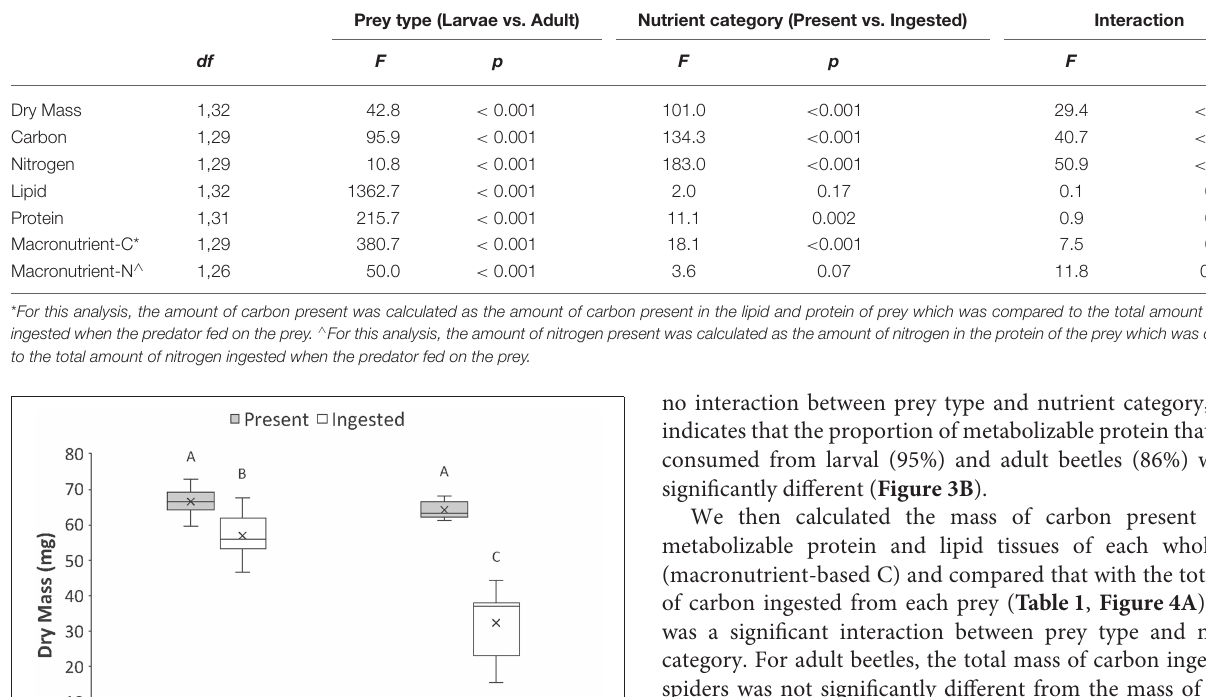
TABLE 1 | Results of the statistical analysis (2-factor analysis of variance) comparing nutrients present in whole prey bodies with nutrients ingested by predators feeding on those prey for larval and adult mealworm beetles. Prey type (Larvae vs. Adult) Nutrient category (Present vs. Ingested) Interaction